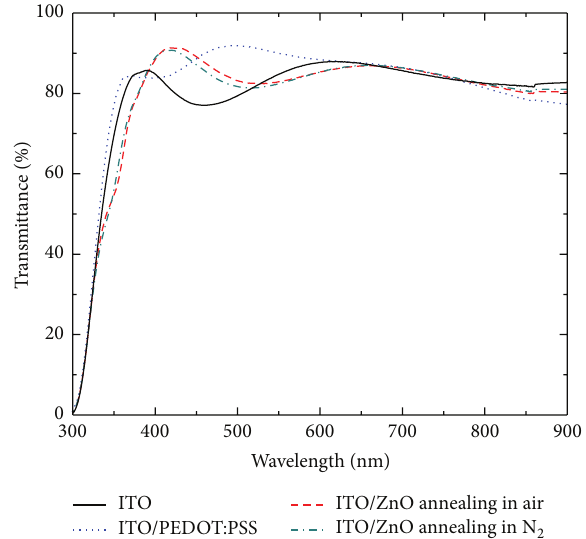
Figure 6: Wavelength-dependent transmittance spectra of ITO, ITO/ZnO annealed in air, ITO/ZnO annealed in N 2 , and ITO/